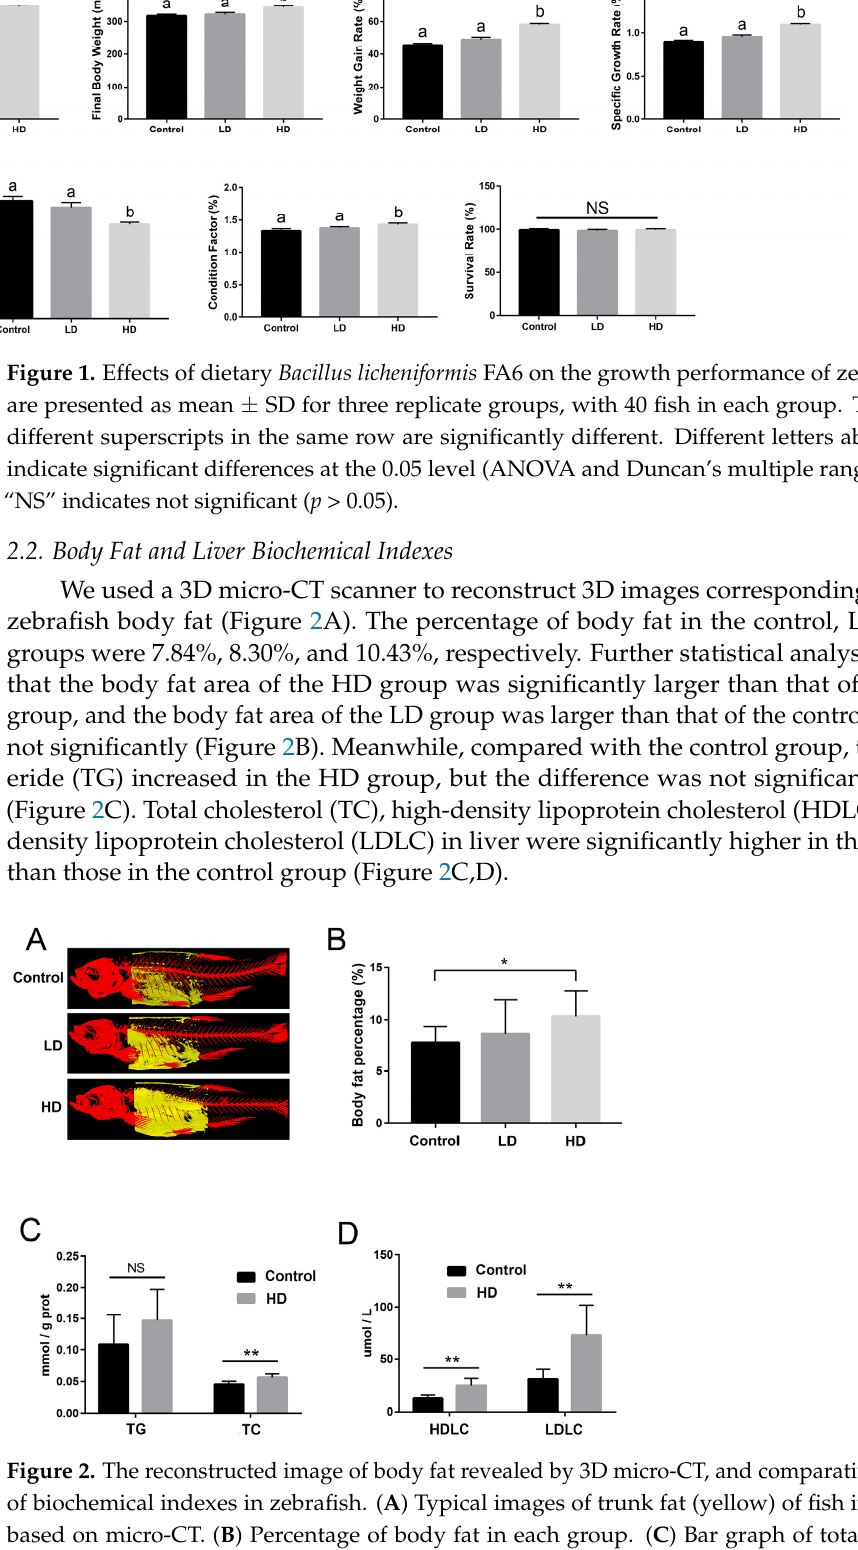
Figure 2. The reconstructed image of body fat revealed by 3D micro-CT, and comparative evaluation of biochemical indexes in zebrafish. ( A ) Typical images of trunk fat (yellow) of fish in each group based on micro-CT. ( B ) Percentage of body fat in each group. ( C ) Bar graph of total triglyceride (TG) and total cholesterol (TC) content in the liver of the control and HD groups. ( D ) Bar graphs of high-density lipoprotein cholesterol (HDLC) and low-density lipoprotein cholesterol (LDLC) levels in the liver of the control and HD groups. * p -value < 0.05 compared with the control group. ** p -value < 0.01 compared with the control group. “NS” indicates not significant ( p >